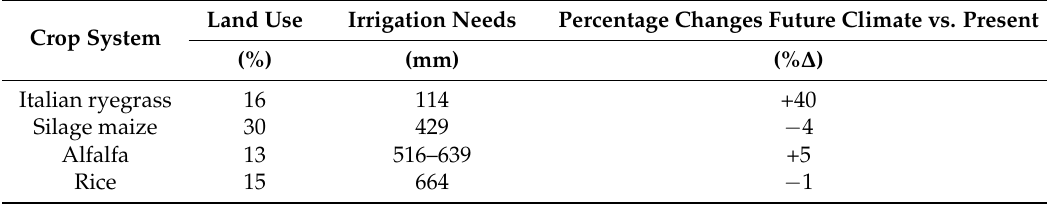
Table 1. Representative values for land use (%), irrigation needs (seeding to harvest in annual crops or annual values in alfalfa) under observed climate, and percentage changes of irrigation requirements under near-future climate vs. present climate (% ∆ ). Land Use Irrigation Needs Percentage Changes Future Climate vs. Present Crop System